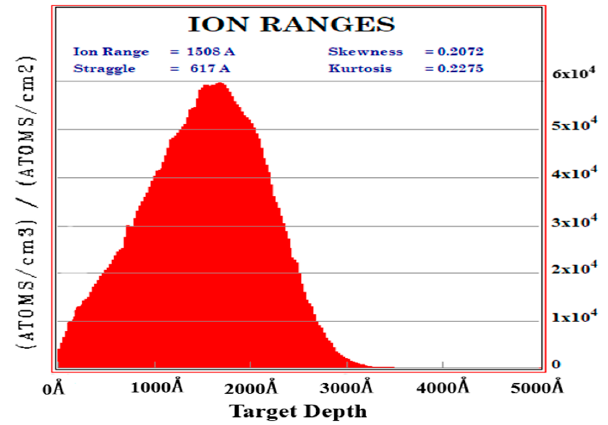
Figure 4. The Be ion range distribution of 50 keV into GaN thin film.